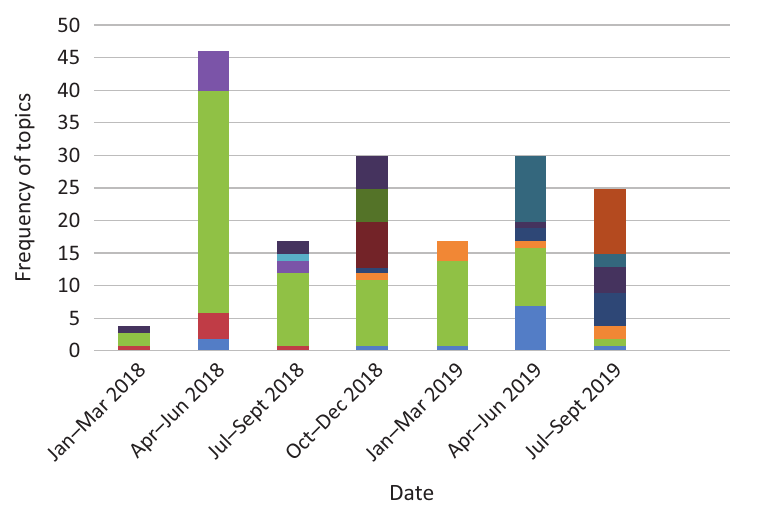
Figure 2. Frequency of privacy topics from January 2018 to September